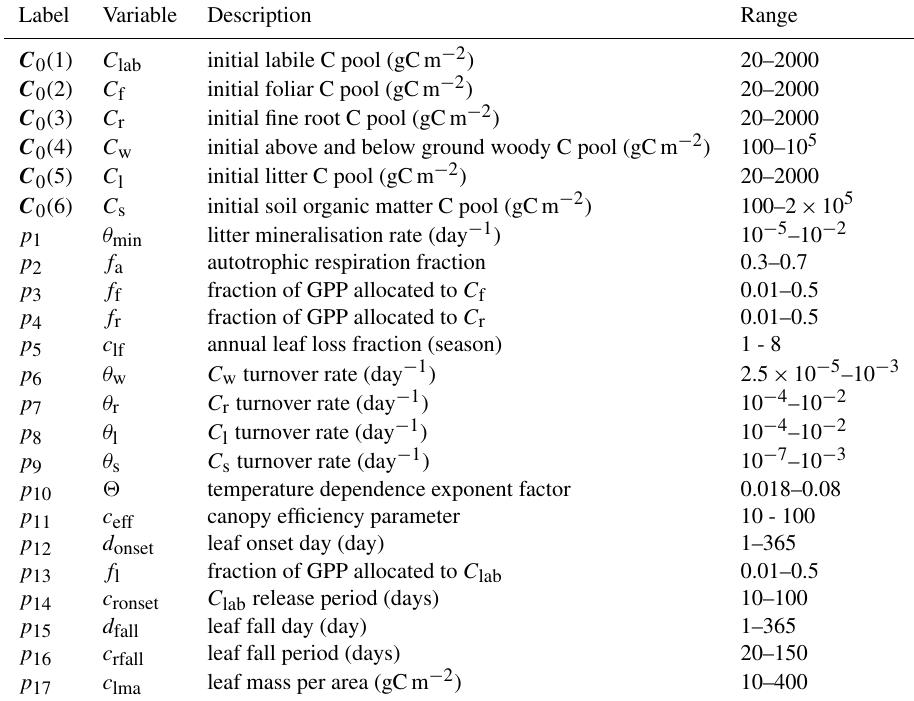
Table 1. DALECv2 dynamical variables and parameters with their respective range. The units of the non-dimensionless quantities are given in